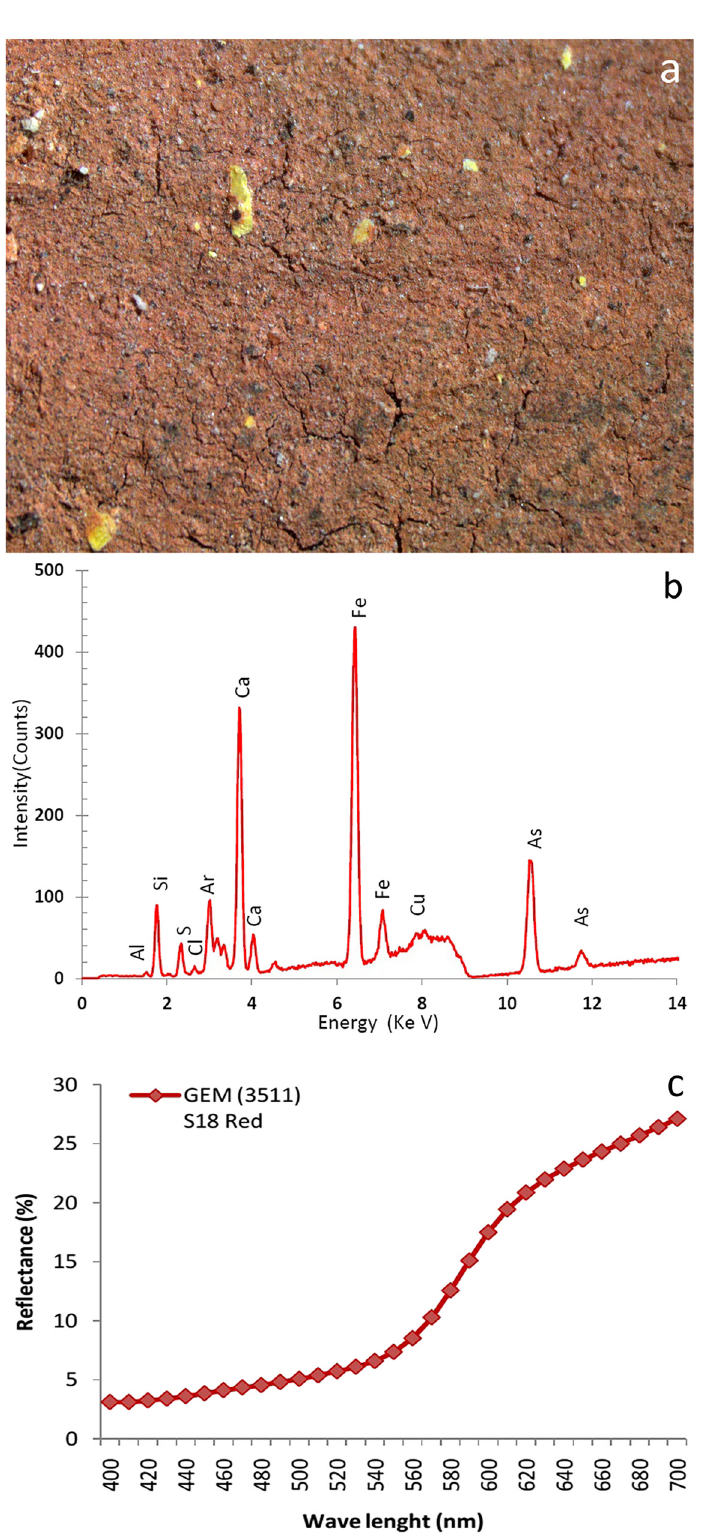
Figure 6: Characterization of the red painted layer ( Object GEM 3511, Spot 18 ) : ( a ) An optical micrograph; ( b ) XRF spectrum; and ( c ) visible re fl ectance